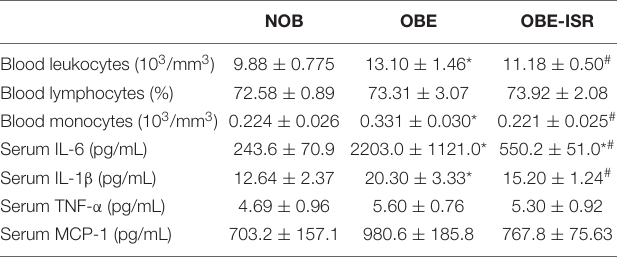
TABLE 3 | Serum immunological markers of the different experimental groups fed on the different experimental diets for 4 weeks to induce